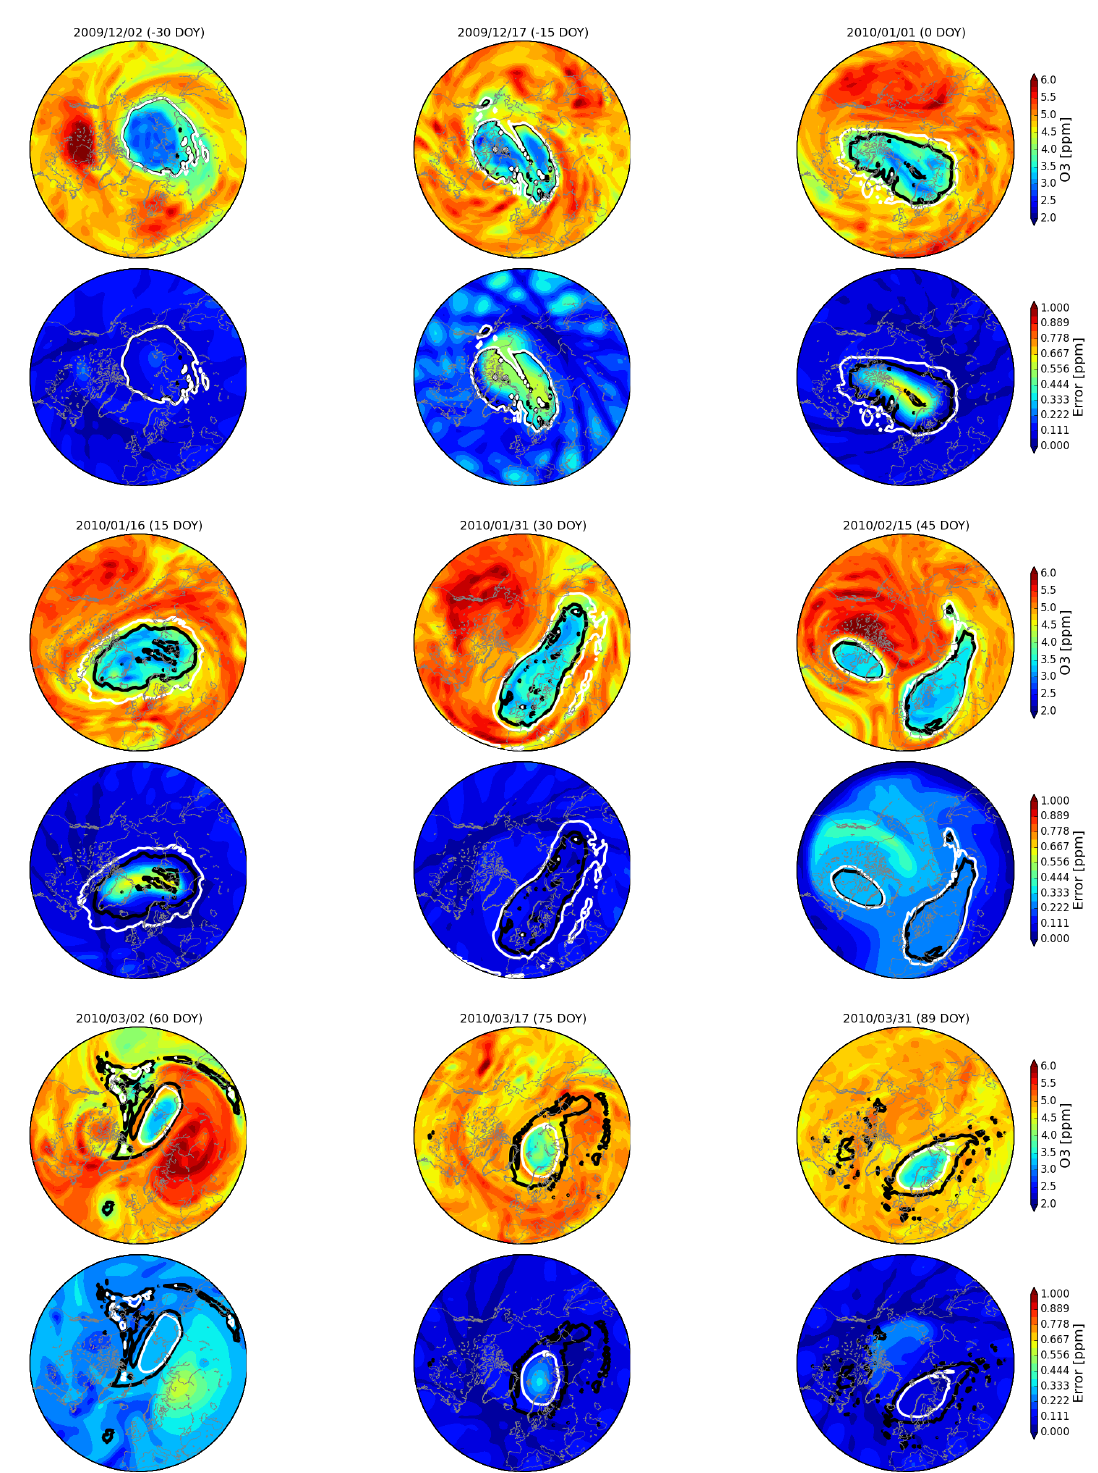
Figure 7. Same as Fig. 4 but for ozone derived from Fig. 7: Same as figure 4 but for ozone derived from SMILES.